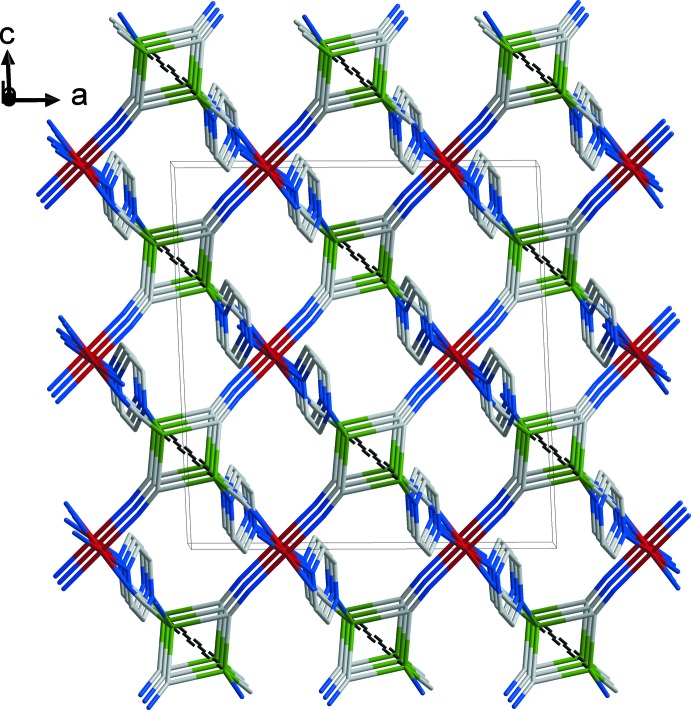
A view normal to the ac plane of the crystal structure of the title compound showing the Cu⋯Cu contacts as dashed lines. Ethyl substituents of 2-ethyl­pyrazine rings and H atoms have been omitted for clarity. Colour code: Fe dark red, Cu green, C grey, N blue.